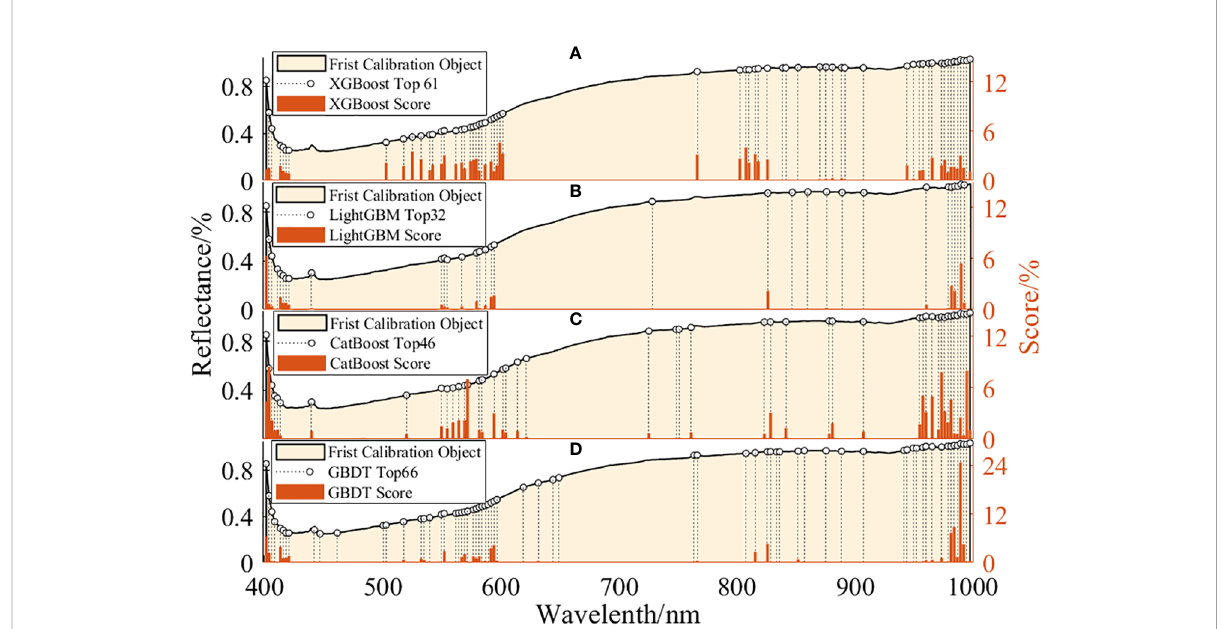
FIGURE 7 Characteristic wavelength distribution and contribution rate of characteristic wavelengths for four variable selection methods. (A) XGBoost; (B) LightGBM; (C) CatBoost; (D) GBDT.